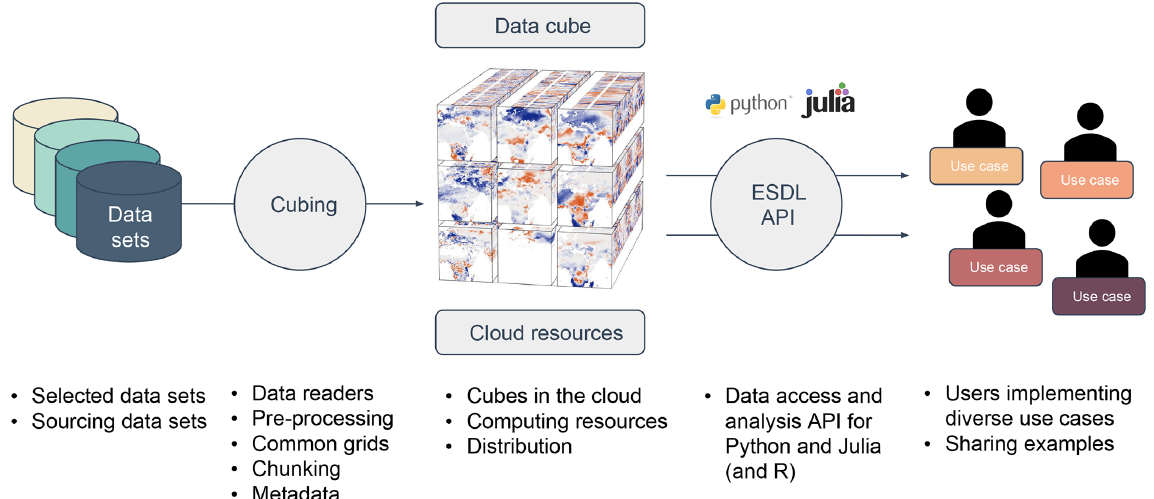
Figure 2. Workflow putting the ESDL concept into practice: selected data sets are preprocessed to common grids and saved in cloud-ready data formats (Zarr). Based on these cubed data sets, a global Earth system data cube can be produced that is either stored locally or in the cloud. Via appropriate application programming interfaces (APIs), users can efficiently access the ESDC in their native language. Users can fully focus on designing user-defined functions and